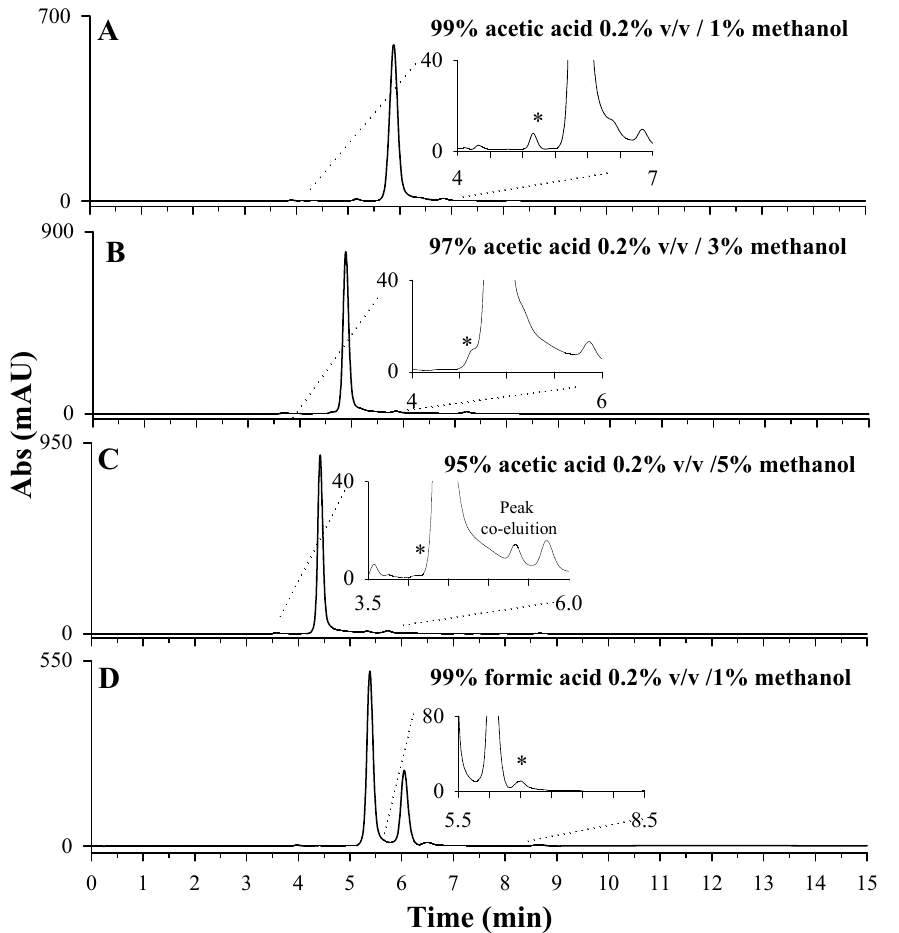
Figure 4. HPLC-UV chromatographic profiles obtained during the optimization of mobile-phase composition: 99% acetic acid 0.2% v / v containing 1% methanol (pH 3.04) ( A ); 97% acetic acid 0.2% v / v containing 3% methanol (pH 3.13) ( B ); 95% acetic acid 0.2% v / v containing 5% methanol (pH